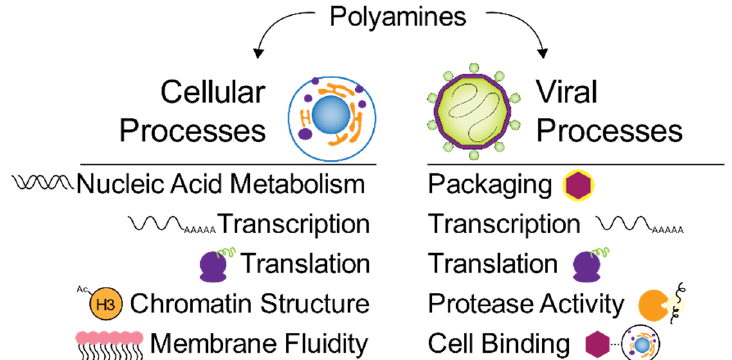
Figure 2. Polyamines in cellular and viral processes. Cells rely on polyamines for transcription, translation, nucleic acid metabolism and structure, chromatin and DNA packaging, and membrane fluidity. Viruses similarly utilize polyamines for transcription, translation, and nucleic acid packaging, but they also use polyamines in binding to cells and for enhancing virus enzyme activity.